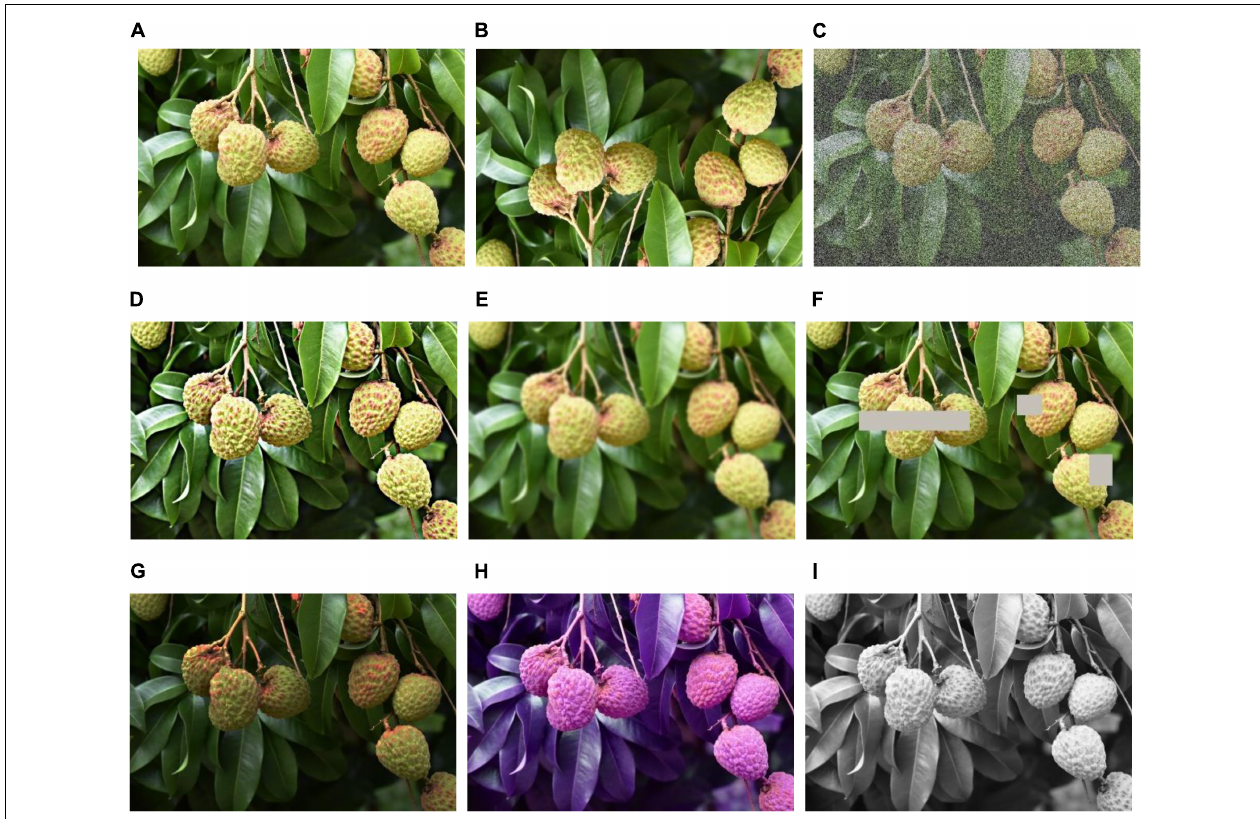
FIGURE 5 | Example images with different image processes. (A) Original image, (B) vertical flip image, (C) noise injected image, (D) sharpened image, (E) Gaussian blurry image, (F) random erased image, (G) image with brightness adjustment, (H) RGB2GRB image, and (I) gray image.